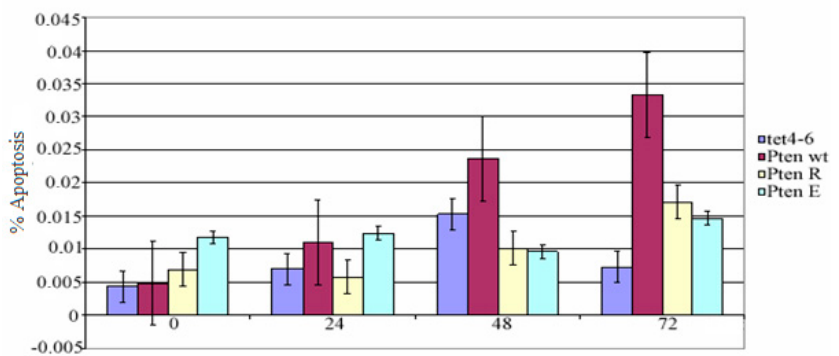
Figure 2. The apoptotic cell count of TET4–6, PTENwt, PTEN G129E and PTEN G129R transfected PC 14 cells between 0–72